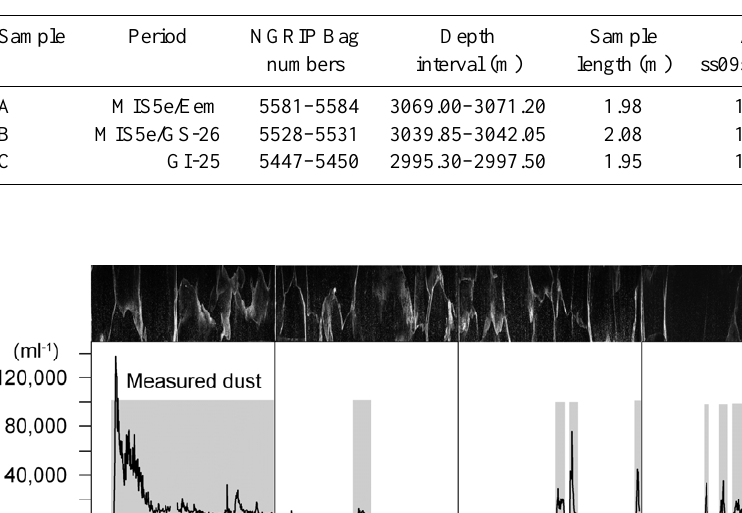
Table 1. List of samples. The sample length is after removal of breaks and end pieces.